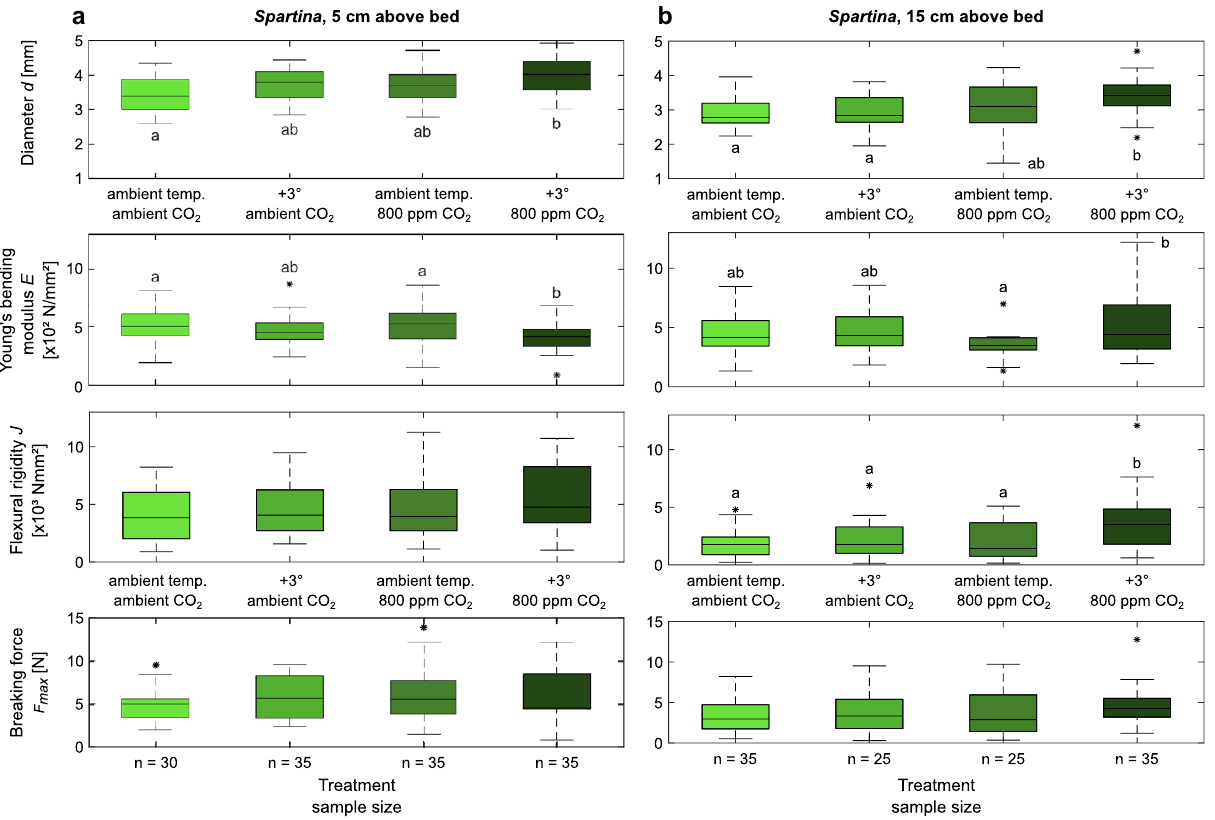
Figure 2. Comparison of vegetation traits between treatments and location along the stem for Spartina . ( a ) Measurements 5 cm above the base, ( b ) Measurements 15 cm above the base. Central marks of the boxplots indicate the median, boxes give inter-quartile range (IQR) and whiskers are maximum and minimum values within the 1.5 × IQR of the hinge. Outliers are indicated by an asterix each (*). Letters indicate results of Tukey– Kramer post-hoc Test, if statistically significant differences were identified. Sample sizes apply to all data in the respective